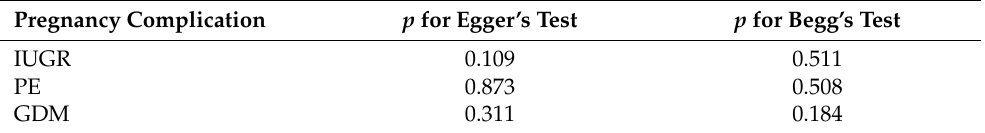
Figure 5. Funnel plots ( A – C ) and sensitivity analyses ( D – F ) for the included studies involved in intrauterine growth restriction, preeclampsia, and gestational diabetes mellitus, respectively. SMD, standard mean difference. Table 2. Publication bias examined by Egger’s linear regression test and Begg’s rank correlation test 1